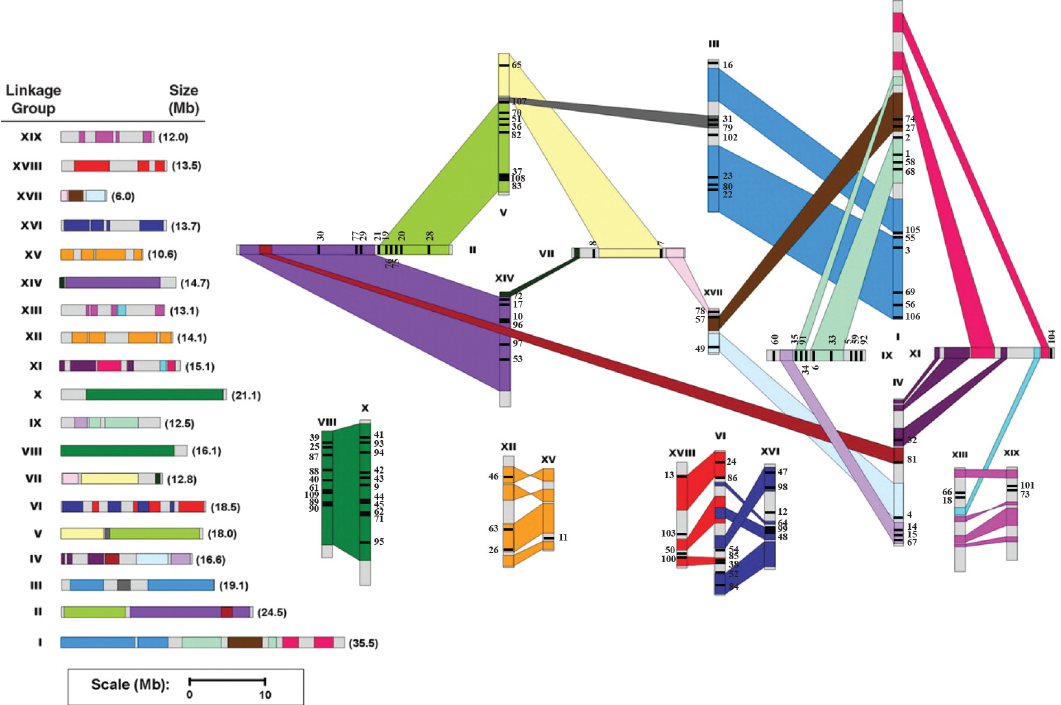
Fig 2. Chromosomal locations of Populus C2HC2-ZF genes. One hundred and nine C2HC2-ZF genes were mapped to 19 linkage groups (LG). A schematic view of chromosome reorganization caused by recent whole-genome duplication in Populus is shown (adapted from [32]). Segmental duplicated homologous blocks are indicated by the same color. The scale represents mega bases (Mb). The LG numbers are indicated above each bar.